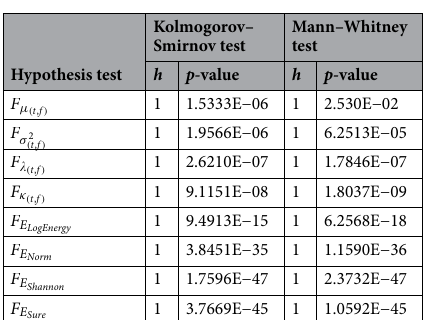
Figure 11. Distribution of the F E